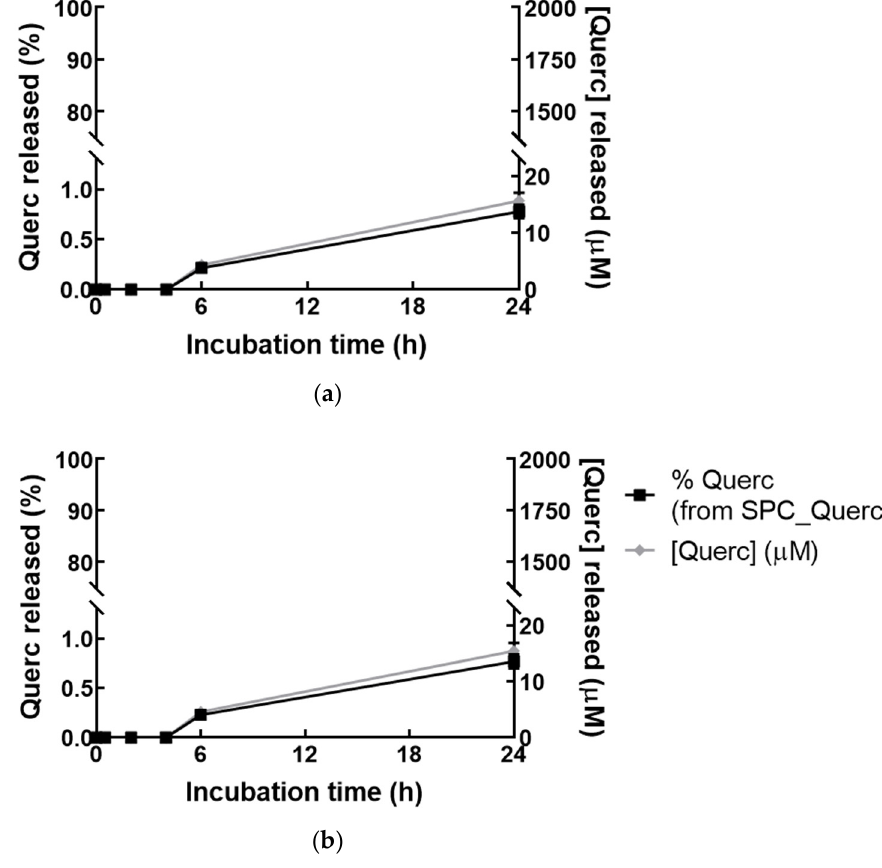
Figure 3. Quercetin release from liposomal formulation. Percentage of quercetin (Querc) released from the initially incorporated drug (%) in SPC_Querc formulation and the correspondent quercetin concentration ([Querc]) released in PBS with 1% ( w / v ) BSA ( a ) or PBS ( b ), during 24 h. Values represented as mean ± SD ( n = 3).